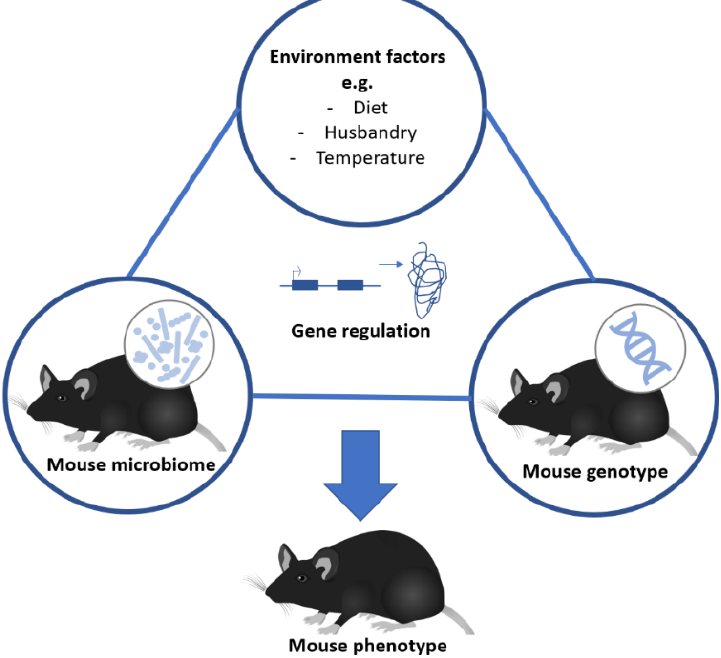
Figure 1. Complex interactions between environment, mouse genotype and mouse microbiome might affect mouse phenotype.